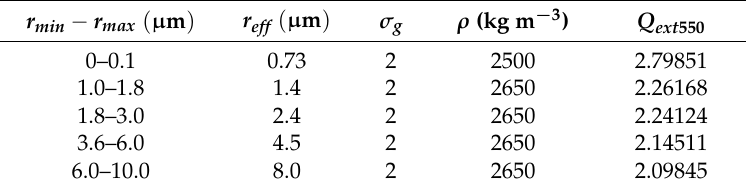
Table 1. Extinction efficiencies at 550 nm ( Q ext 550 ) for the dust sub-bins of WRF-CHEM. The sub-bin characteristics are also provided, in terms of the minimum ( r min ) and maximum ( r max ) radius, the effective radius ( r ef f ) and the geometric standard deviation ( σ g ) of the sub-bin lognormal size